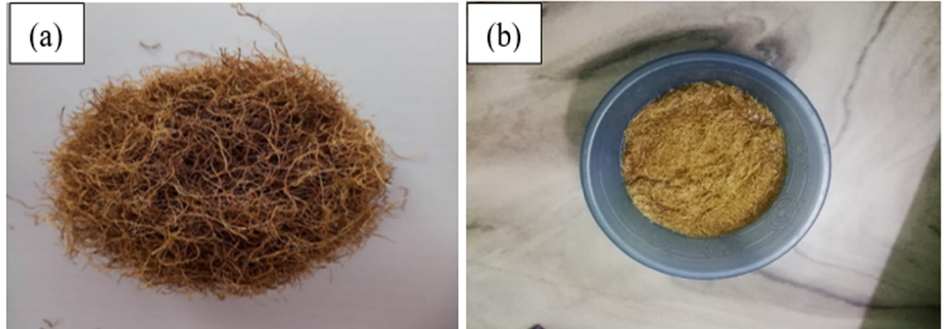
Figure 2. ( a ) Untreated Zm fi bres; ( b ) 0.1 M alkali treated Zm fi